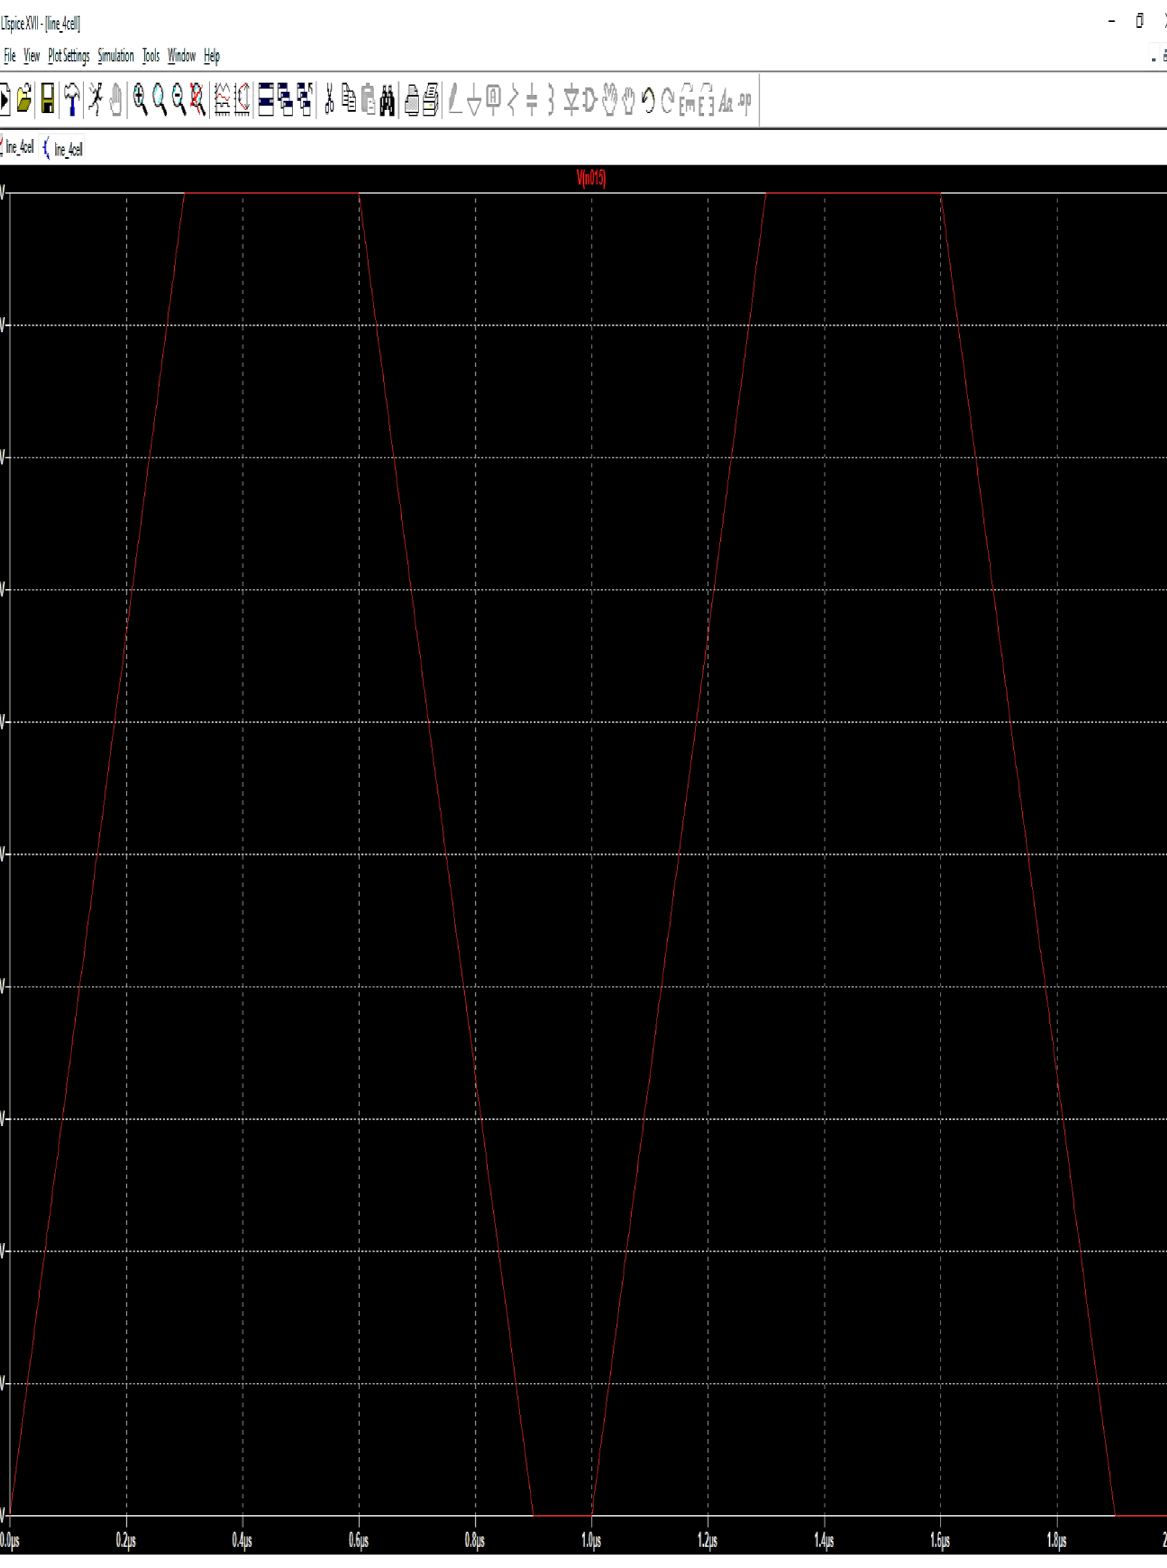
Figure 8. Signal captured at node